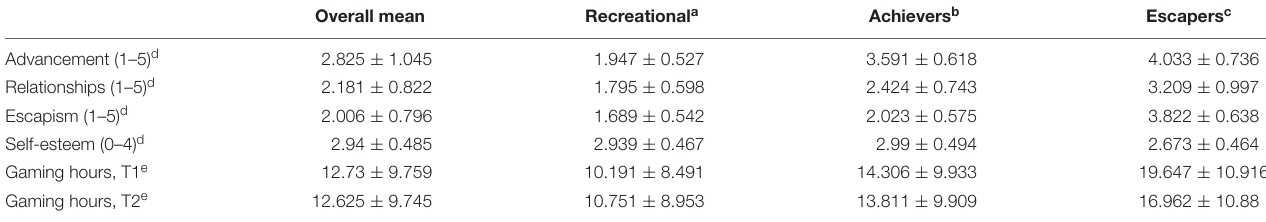
TABLE 2 | Baseline characteristics by subgroup.